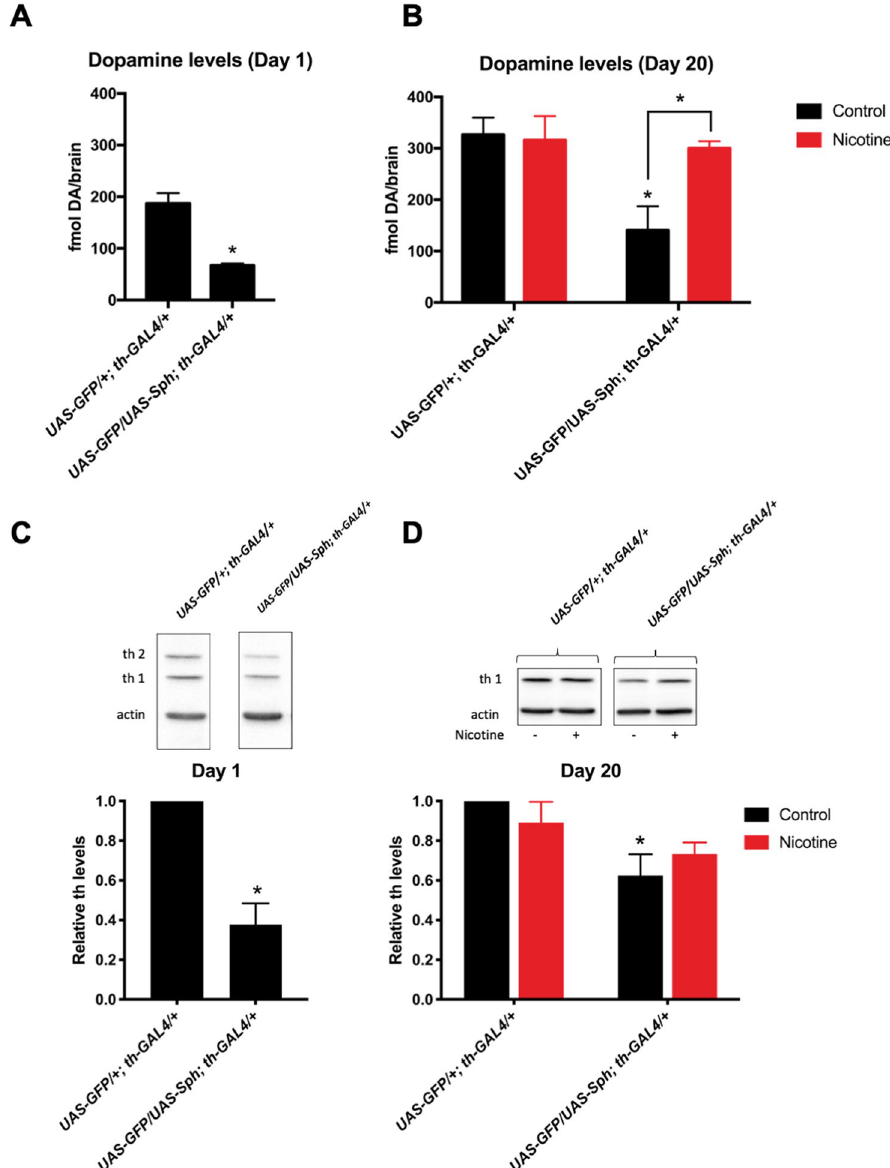
Figure 6. Nicotine exposure increases brain dopamine and tyrosine hydroxylase levels. ( A ) Newly eclosed flies (one day old) that express Sph-1 ( UAS-GFP/UAS-Sph; th-GAL4/ +) show reduced dopamine brain levels compared with control (UAS- GFP/+; th-GAL4/+) flies. * p < 0.05, t-test ( B ) After 20 days of aging, dopamine levels are reduced in animals that express Sph-1 compared with control flies (# p < 0.05). 20 days of chronic nicotine treatment induces an increase in dopamine brain levels in Sph-1 expressing flies (* p < 0.05) so amine brain content becomes similar to levels recorded in control flies. Dopamine levels in control animals are not affected by the nicotine treatment. In each case, data from controls were represented in black bars; data from animals treated with nicotine were represented in red bars. Statistical analysis after two-way ANOVA and Tuckey’s post-hoc test (n = 5 samples, each consisting of 5 fly brains). ( C ) At day one, tyrosine hydroxylase isoform 1 (th1) protein levels are reduced in flies that express Sph-1 ( UAS-GFP/UAS-Sph; th-GAL4/ +) when compared with control flies (UAS-GFP/+; th-GAL4/+), as can be observed in a representative experiment (top panel) in young flies. The higher MW cuticle-specific tyrosine hydroxylase isoform 2 (th2) can also be detected; this isoform stops being expressed as soon as the fly´s cuticle is melanized and cannot be detected in aged flies. Quantification of several blots from independent experiments (bottom panel) show significant reduction in tyrosine hydroxylase protein levels (th1). * P < 0.05; t-test compared with control strain; n = 3 different samples obtained from independent groups of animals. ( D ) At day twenty, untreated Sph-1 expressing flies show lower tyrosine hydroxylase levels compared with control animals, as evidenced in a typical experiment (top panel). Quantification of several blots from three independent biological samples (bottom panel) show a significant lower protein expression in Sph-1 expressing flies (* P < 0.05). Nicotine treatment promotes an increase of tyrosine hydroxylase to normal levels compared with the control genotype ( p > 0.05). Statistical analyses with two-way ANOVA and Tuckey’s post-hoc test, in n = 3 independent samples. In all cases experimental animals were treated with 24 µM nicotine, full blots used for quantifications are shown in Supplementary Fig.